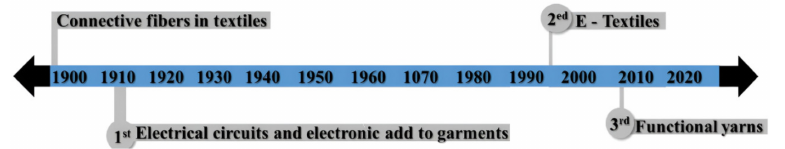
Figure 1. This timeline shows different generations of electronic textiles. Adapted